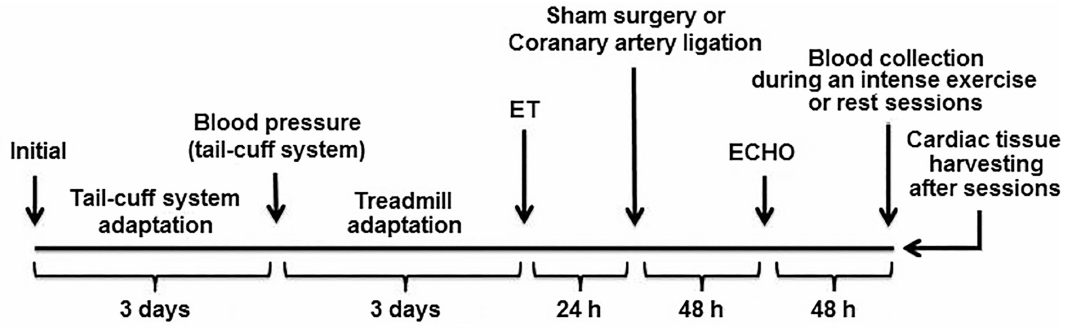
Figure 1 - Experimental design. A 3-day adaptation for acquisition of blood pressure by the tail was performed. On the 4th day, blood pressure and heart rate were recorded. Then, the animals were allowed to adjust to exercise on a treadmill for 3 days (0.3 km/h, 15 min/day). On the 4th day, the maximal exercise test was performed. Twenty-four hours later, the animals underwent sham surgery or acute myocardial infarction induced by left coronary artery ligation. AMI was confirmed after 48 hours by echocardiography (ECHO). Finally, blood was collected from the animals during an intense exercise ses- sion (SE and IE groups) or at rest for the same period (S and I groups). The heart was removed immediately after this